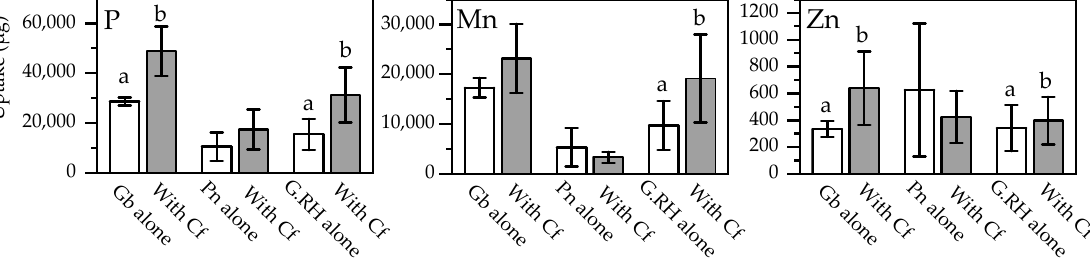
Figure 7. Total uptake of P, Mn, and Zn into foliage of each of the three species of Protea, when they were growing alone or with Dactylis glomerata (cocksfoot): Gb: Grevillea barklyana , Pn: Protea neriifolia , G.RH: Grevillea Robin Hood, Cf: Cocksfoot. Open bars, first sampling; shaded bars, final sampling. Different letters each indicate significant differences ( p < 0.05) within each of the sampling events. Elements without significant differences are not shown (full data in Appendix A, Table